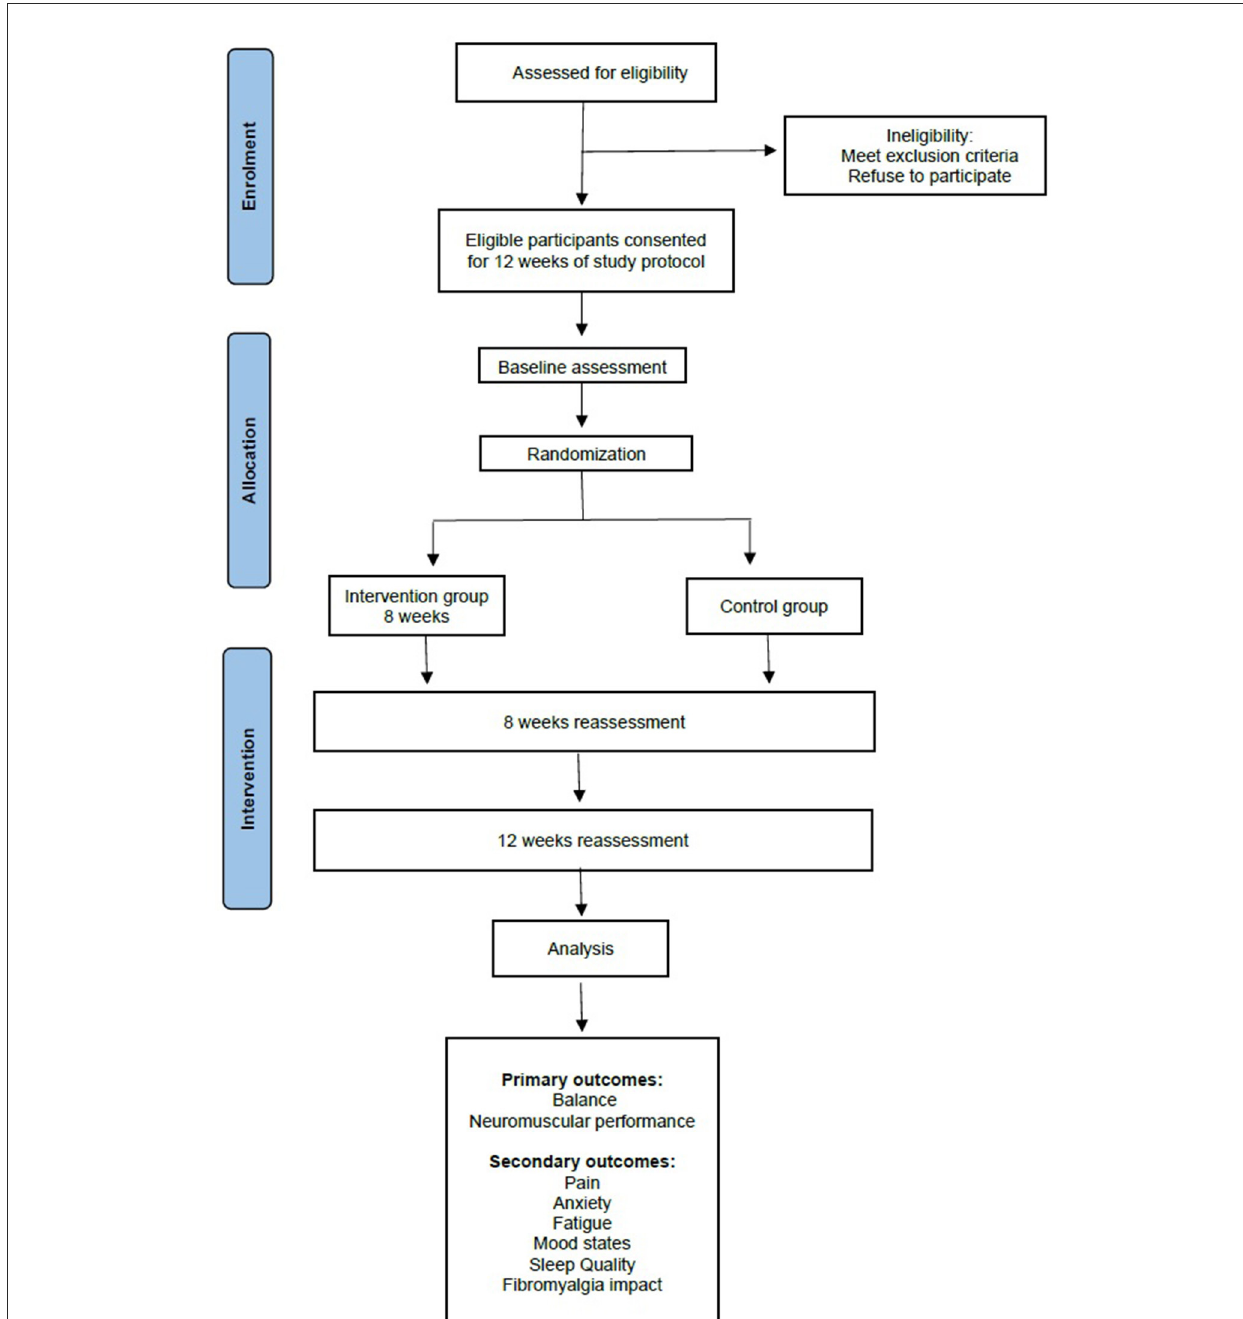
FIGURE1 Flow diagram of the